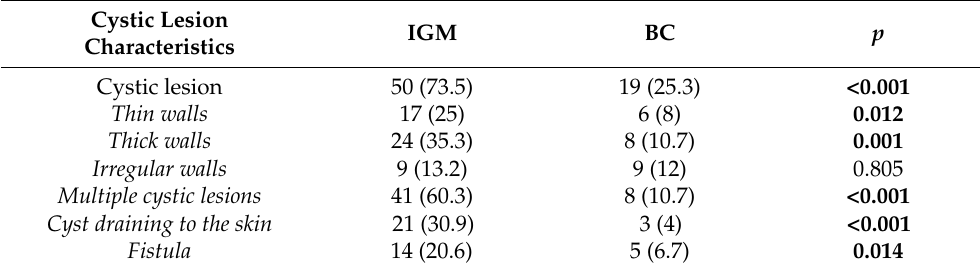
Table 5. Cystic lesion characteristics for IGM and breast cancer (BC).